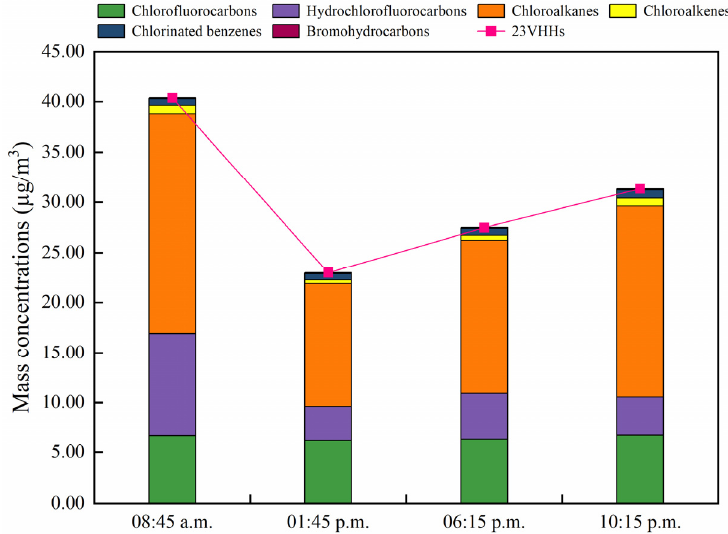
Figure 7. Diurnal variation of the average mass concentration volatile halogenated halocarbons in the study area.